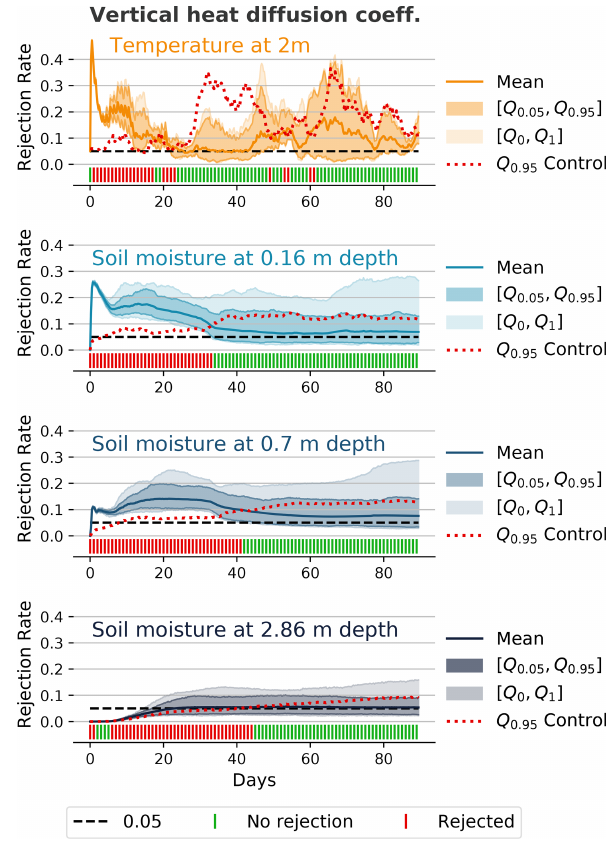
Figure 6. Rejection rates and decisions similar to Fig. 3 for the 2m temperature and soil moisture at different depths for an ensem- ble where the minimal diffusion coefficient for vertical scalar heat transport has been slightly changed ( tkh min = 0 . 3 instead of 0.35) and with n E = 50, n S = 20, and m = 100. The initial random per- turbation of the atmosphere needs some time to travel to the deeper soil layers. While the magnitude of the rejection rate is significantly lower for the deeper soil layers, the difference is noticeable for a longer period of time.